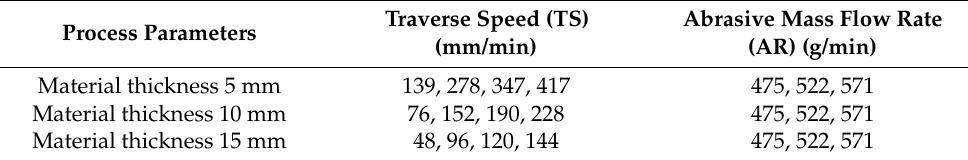
Table 2. Input process parameters and their values used in the experiments.